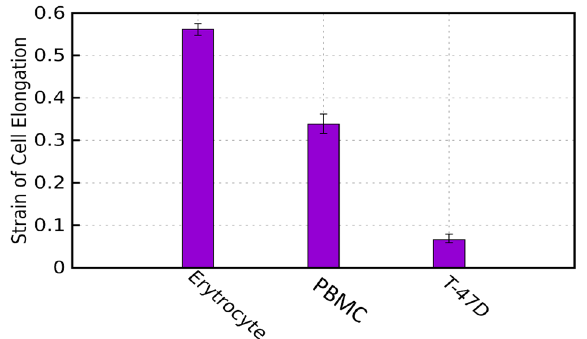
Figure 9. Lumped property parameter (S) for three kinds of circulating cells (Erythrocyte, PBMC, and T-47D).